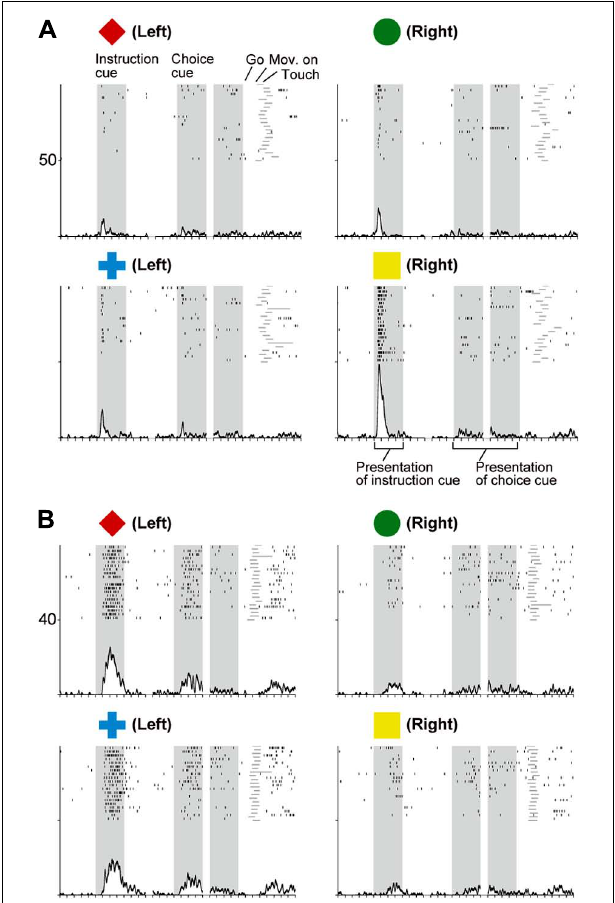
FIGURE 10 |Two examples of neurons in the prefrontal cortex selective for visual objects (A) and behavioral goals (B). (A) Activity of this vlPFC neuron increased when the yellow square was presented. (B) Activity of this dlPFC neuron increased when the instruction was presented and either a red diamond or a blue cross was used to specify the left target.The display formats are the same as those used in Figure 7 (adapted from Yamagata etal.,